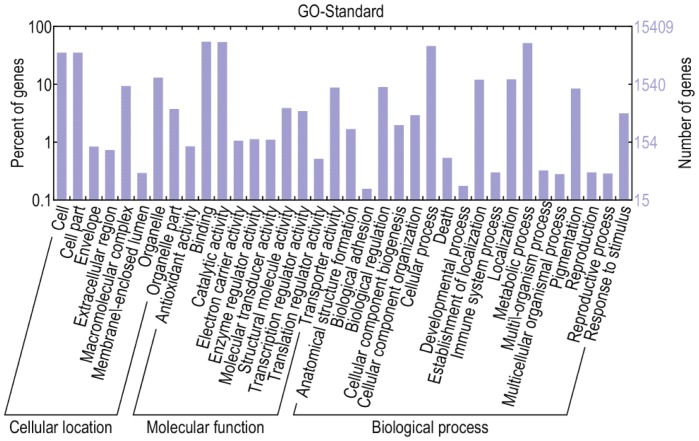
Gene Ontology classifications of assembled unigenes.The unigenes are summarized into three main categories: biological process, cellular location, and molecular function. In total, 15,409 unigenes with BLASTx matches were assigned to gene ontologies.